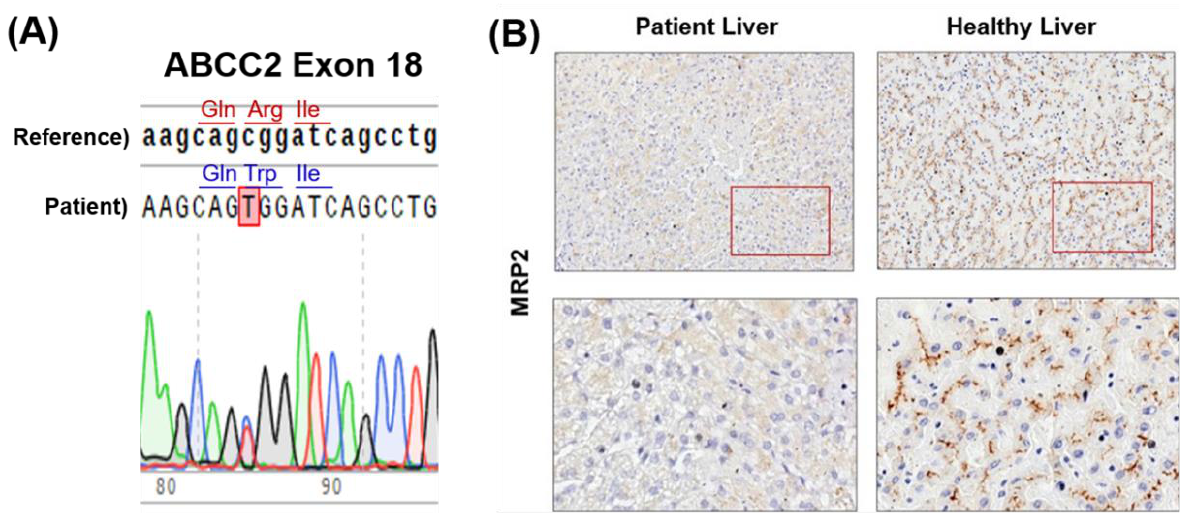
Figure 3. ( A ) ABCC2 mutation study of exon 18. ( B ) Immunohistochemical staining of multidrug resistance-associated protein 2 (case patient vs. healthy subject). resistance-associated protein 2 (case patient vs. healthy